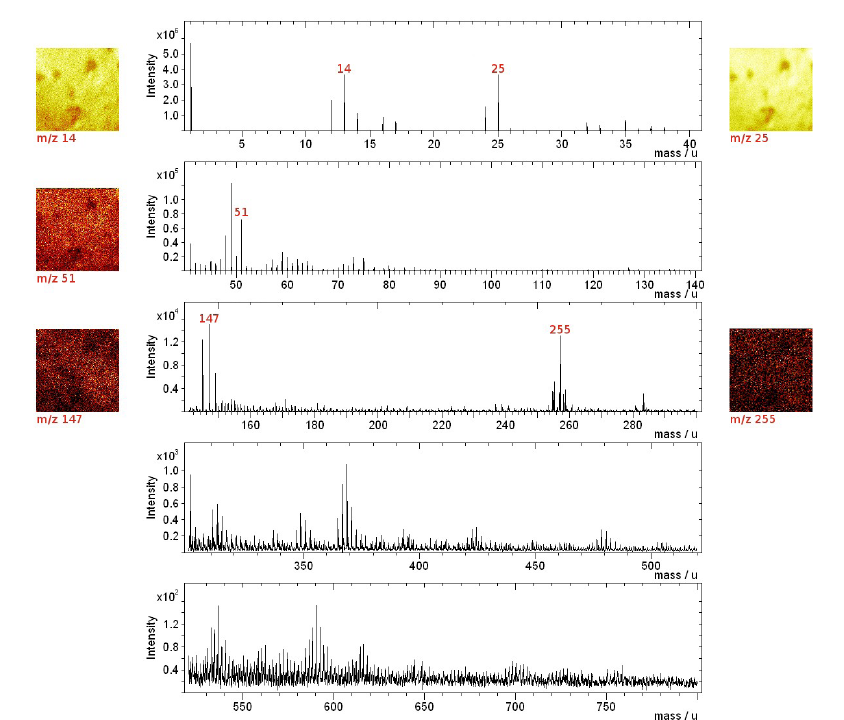
Figure 6. SIMS spectra of mercaptoacetic acid SAM onto the Ag functionalisated with L-Tryptophan in negative mode. Table 2B. Table of fragments of mercaptoacetic acid SAM onto the Table 2C. Table of fragments of hexadecanethiol SAM onto the Ag Ag functionalisated with L-Tryptophan in negative mode. functionalisated with L-Tryptophan in negative m/z